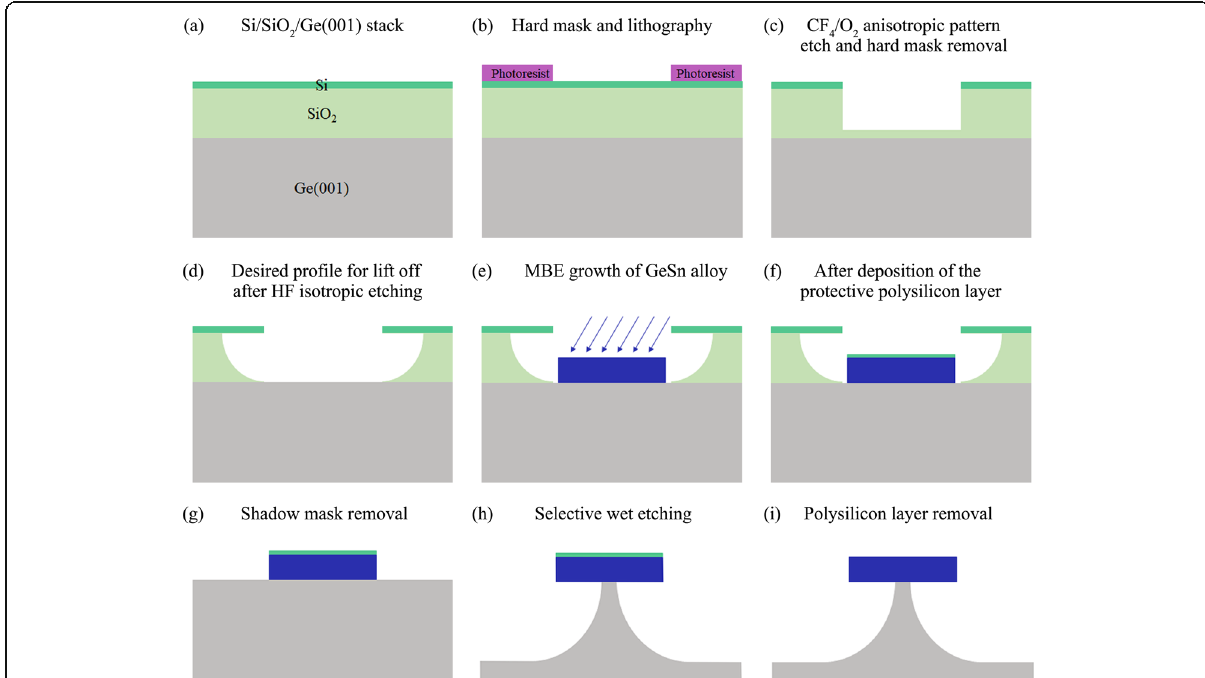
Fig. 1 The cross-sectional schematics illustration for the fabrication of the suspended GeSn microdisks